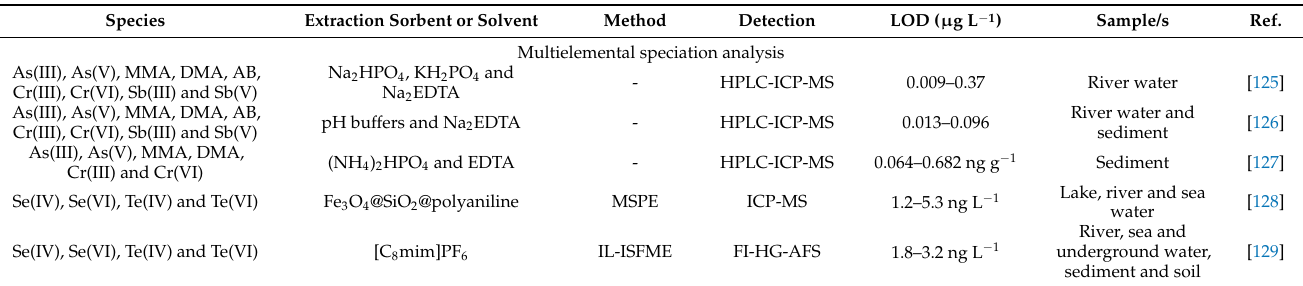
Table 3. Multielemental speciation analysis reports from 2016